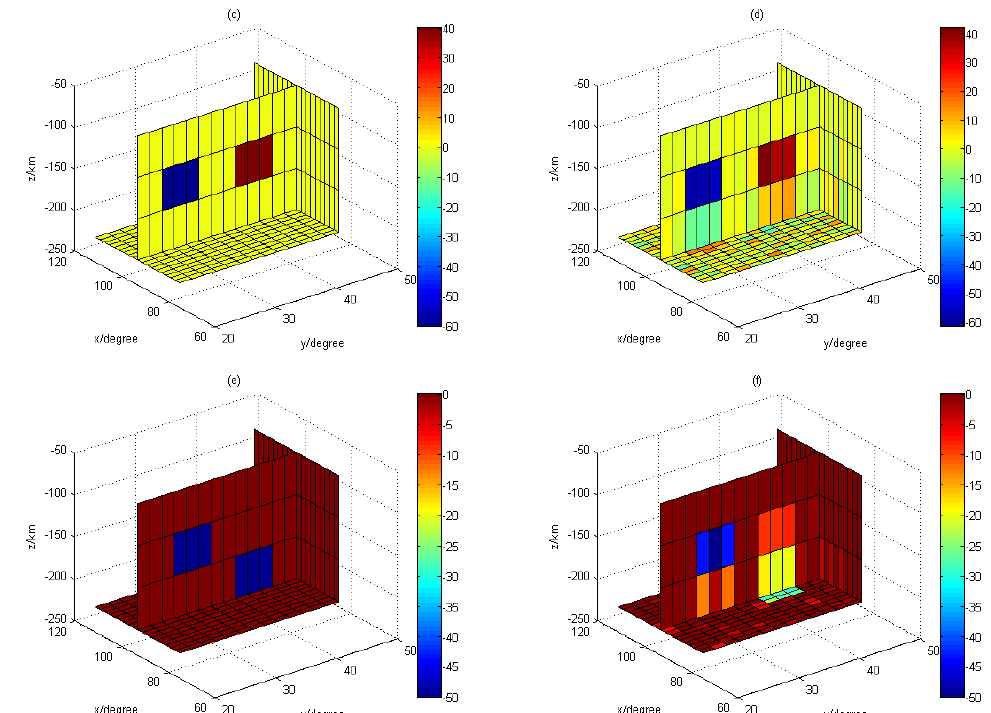
Figure 3. ( a ) Synthetic M1; ( b ) Estimated M1; ( c ) Synthetic M2; ( d ) Estimated M2; ( e ) Synthetic M3; and ( f ) Estimated M3.